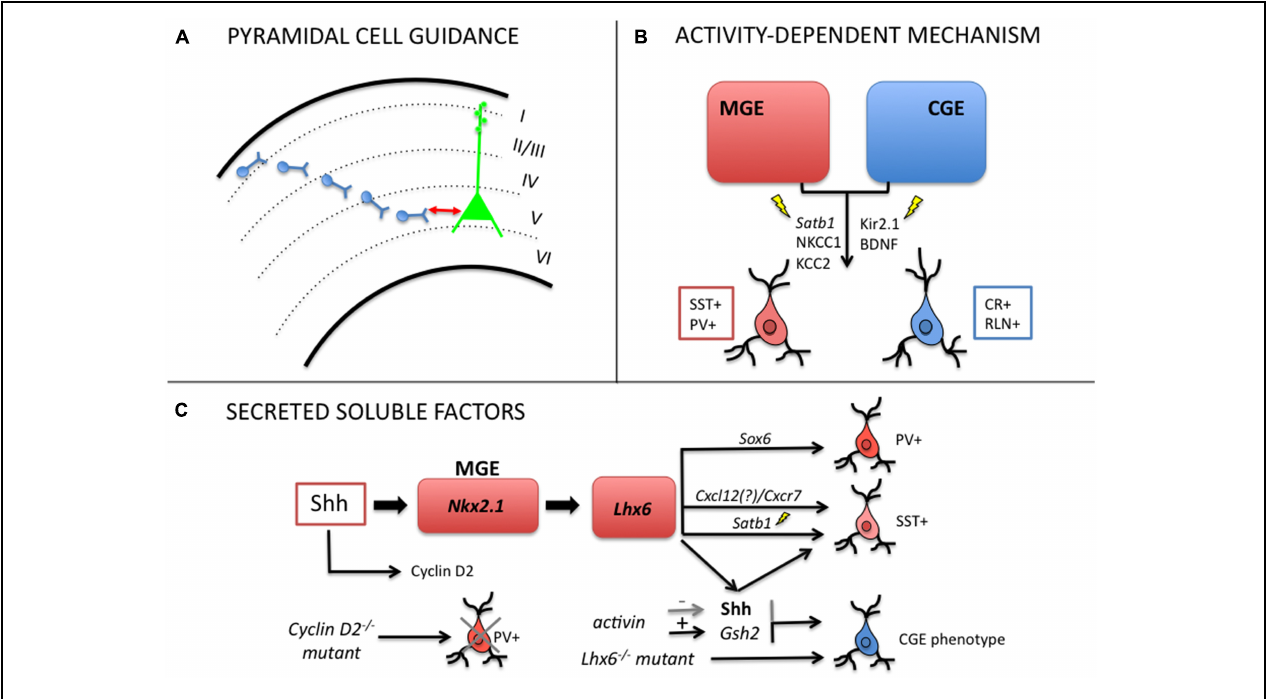
FIGURE 2 | Mechanisms regulating post-mitotic plasticity and late-fate specification of cortical GABAergic interneurons. (A) Local pyramidal cells modulate laminar positioning of inhibitory neurons in the cortex (Pla et al., 2006; Lodato et al., 2011). (B) Electrical activity (GABA-mediated membrane